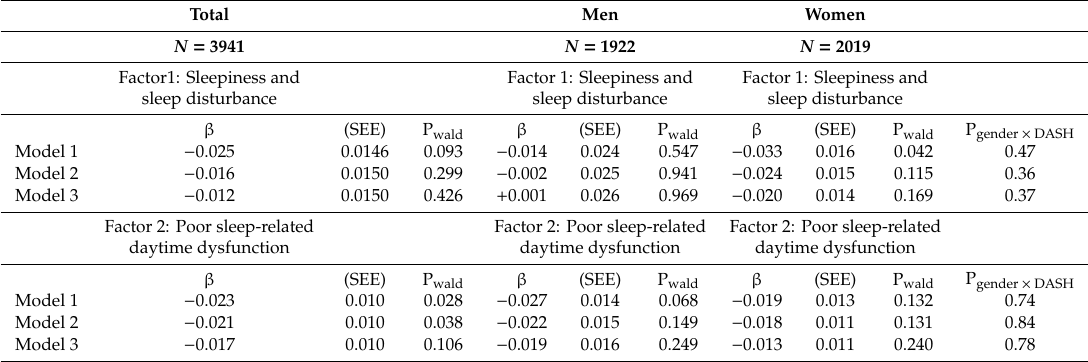
Table 2. DASH total score as a predictor of sleep quality measures, stratified by gender: multiple linear regression models, the NHANES 2005–2008. Total Men Women N = 3941